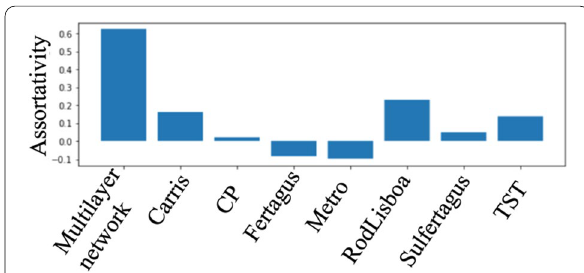
Fig. 8 Assortativity distribution of each layer and the multilayer